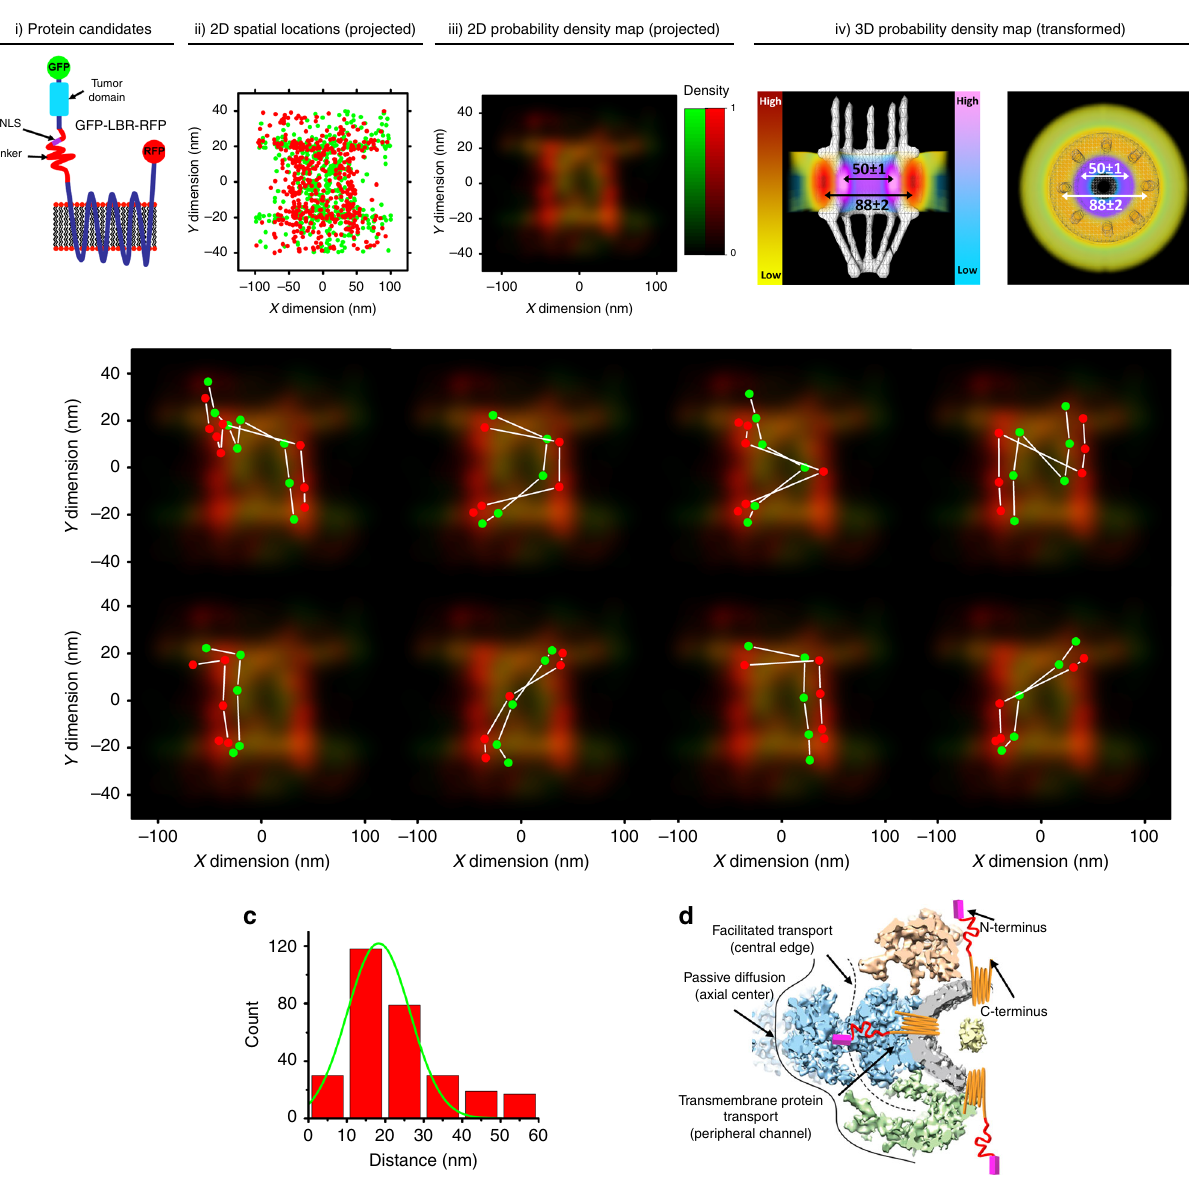
Fig. 3 Simultaneous dual-channel single-molecule tracking of both termini of LBR. a Transport route of LBR tagged with EGFP on the N terminus and RFP on the C terminus (GFP-LBR-RFP). (i) Schematic cartoon representation of each INM protein (orientation N-terminus to the left and C-terminus to the right). The depicted membrane represents a single bilayer of the NE. (ii) 2D spatial locations (projected) of each INM protein candidate. In the X dimension of the Cartesian graph, 0 represents the axial center of the NPC, and in the Y dimension, + 20 represents the ONM, and − 20 represents the INM. (iii) A normalized 2D probability density map showing the regions where the projected single-molecule localizations had the highest and lowest density. (iv) 3D probability density map generated by using the 2D to 3D transformation algorithm 52 , with regions of highest to lowest density (each color bar shows the gradient color change between regions of high and low density). b Typical co-tracking trajectories of GFP-LBR-RFP in the NPC show that the EGFP and RFP tagged termini move in the same direction with close proximity to each other. Green dots represent EGFP, red dots represent RFP. These trajectories have been overlaid on top of the 2D probability density map of GFP-LBR-RFP. c Histogram of ~300 different dual tracked trajectories shows that the average distance between EGFP tagged N terminus and RFP tagged C terminus is ~18 nm during transit through the NPC. No FRET was observed during these experiments further con fi rming that the N and C termini do not transit in the same channel. d Cryo-EM image of the NPC with a cartoon representation of how LBR transits from the ONM to INM ( fi gure modi fi ed from ref. 55 with